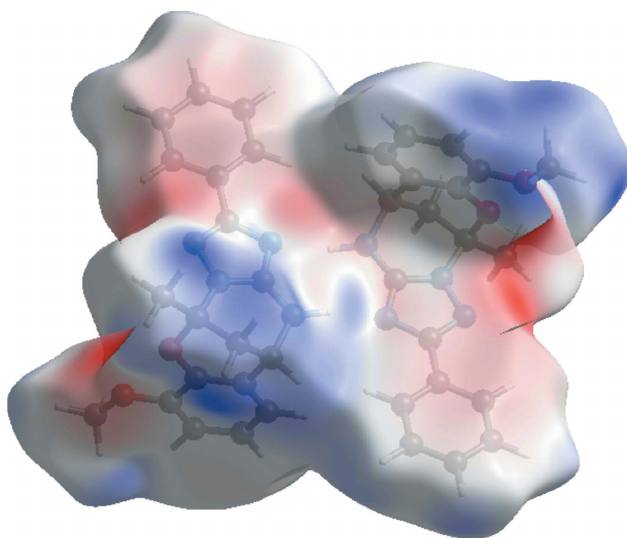
Figure 7 The view of the three-dimensional Hirshfeld surface of the title compound plotted over the electrostatic potential energy.